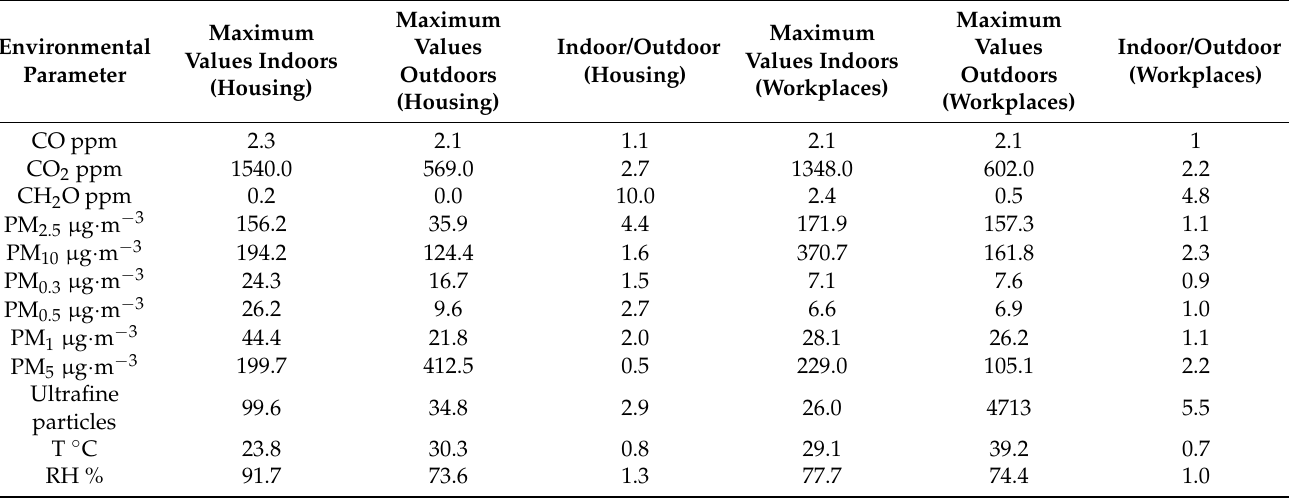
Table 4. Ratio between indoor air quality of buildings and outdoor air